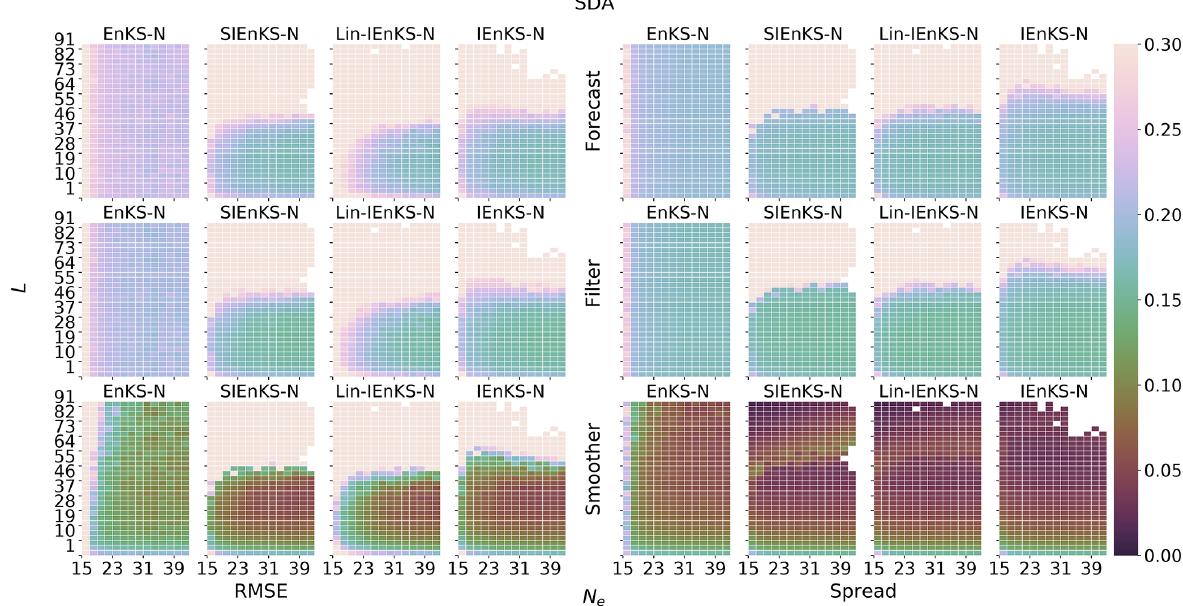
Figure 8. The lag length L is shown on the vertical axis, and the ensemble size N e is shown on the horizontal axis. SDA, adaptive inflation, shift S = 1, linear observations, and (cid:49)t = 0 . 05 are also indicated.